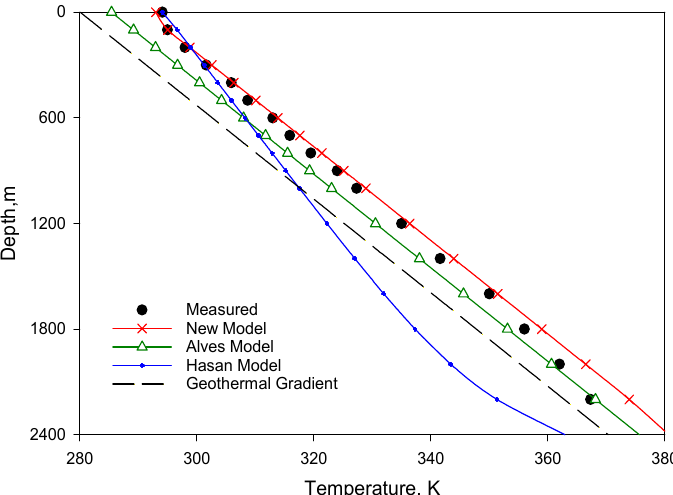
Figure 9. Comparison of data for the Luo Wei Well.